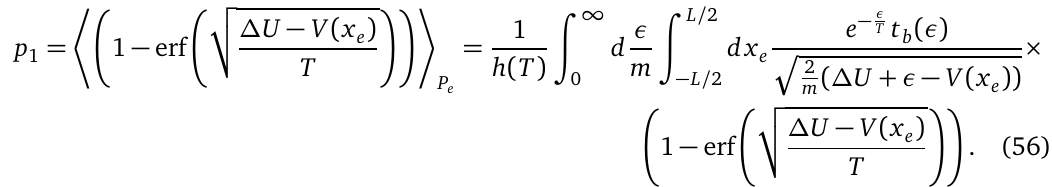
Figure 12: Dependence of the average squared length of the internal flights on ω ticles that perform k = 1 collisions in the arrival well before escaping, ∆ x ∪ = 0. The full line is a lower bound determined under the assumption that a particle thermalizes after performing → 0 limit is L 2 / 2. See Appendix A. Parameters: ∆ U = 1 / 4, L = k > 1 collisions. The ω t b c